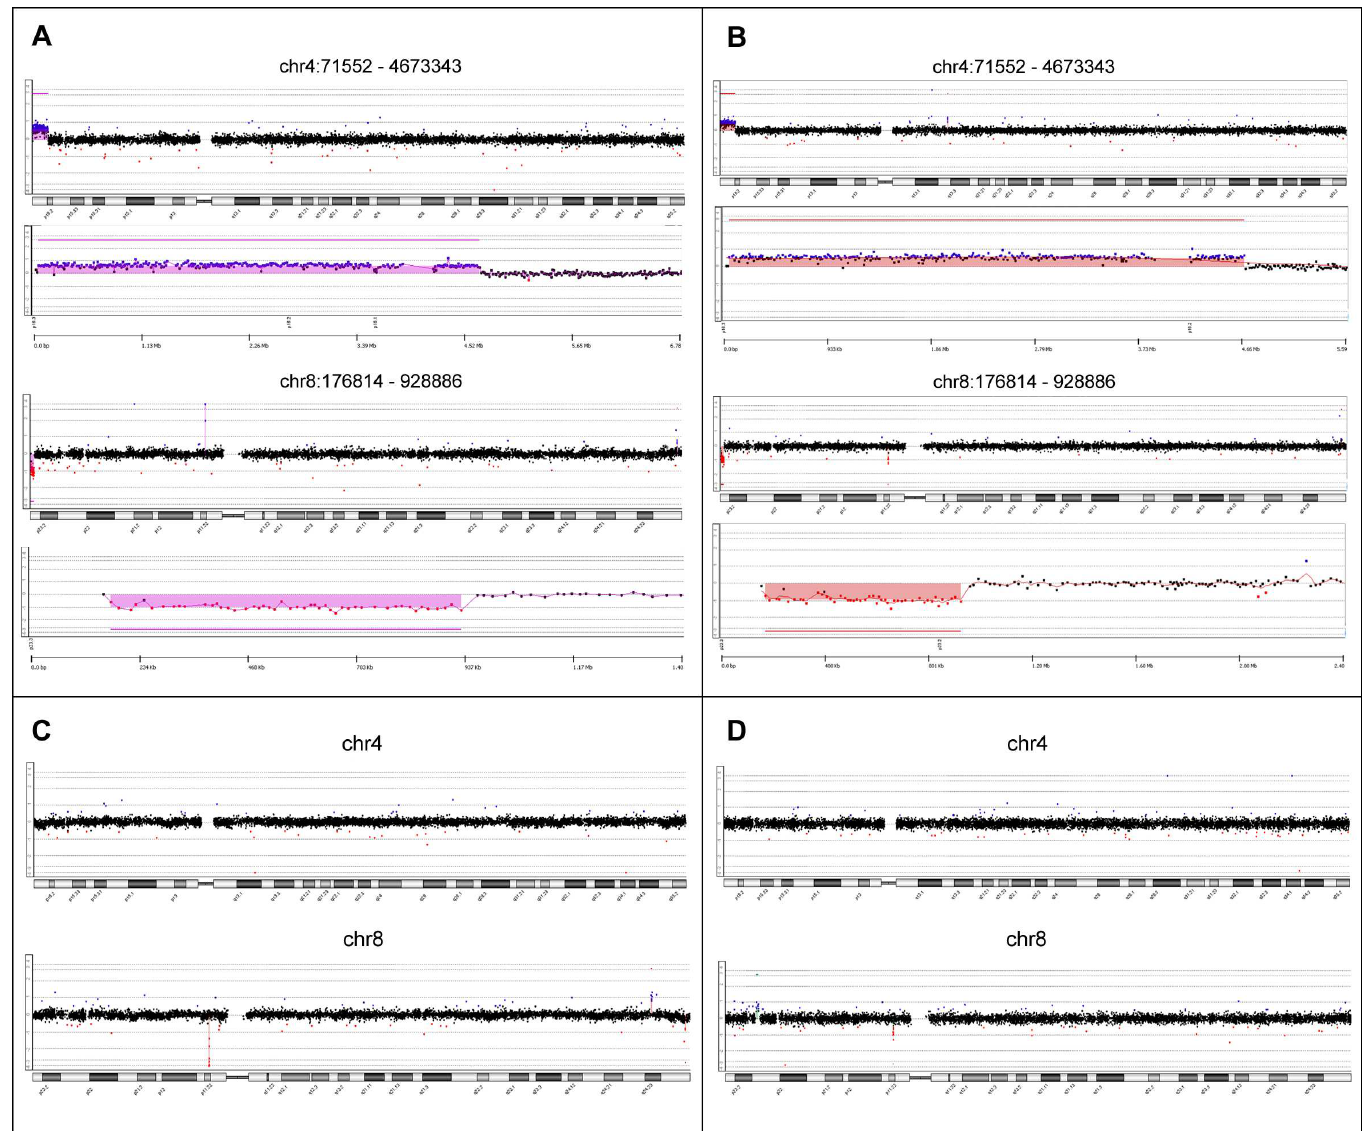
Fig 1. Chromosomal alterations detected with aCGH analysis in both siblings. A and B presentthe aCGH profilesof chromosomes 4 and 8, showingthe 4p16.3duplicationand the 8p23.3deletionin the maleand female siblings,respectively; C and D presentthe normalcopy number profilesof chromosomes 4 and 8 of the father and mother,